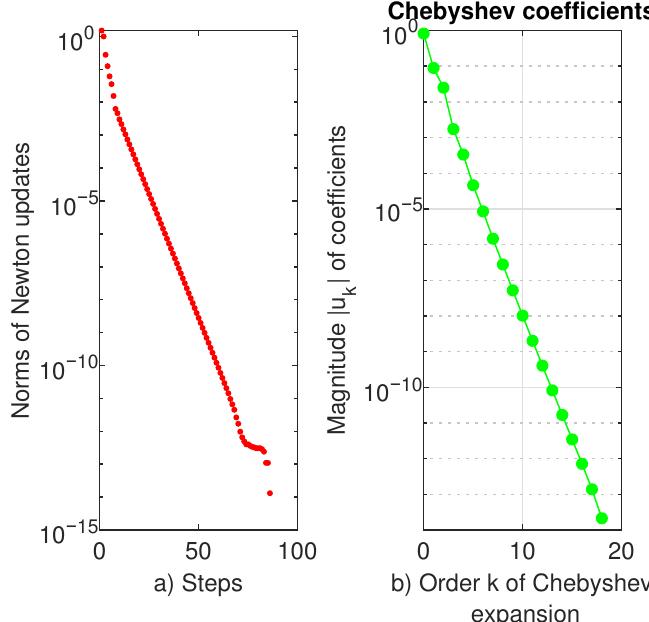
Figure 8. ( a ) The norm of the Newton’s updates when Chebfun computes the solution u ( x ,2/5 ) . ( b ) The Chebyshev coefficients of solution to problem (15) with ν = 2/5. The behavior (almost linear decrease to the machine precision level) of the Chebyshev coefficients of the solution suggests a still exponential convergent process (see the (b) panel in Figure